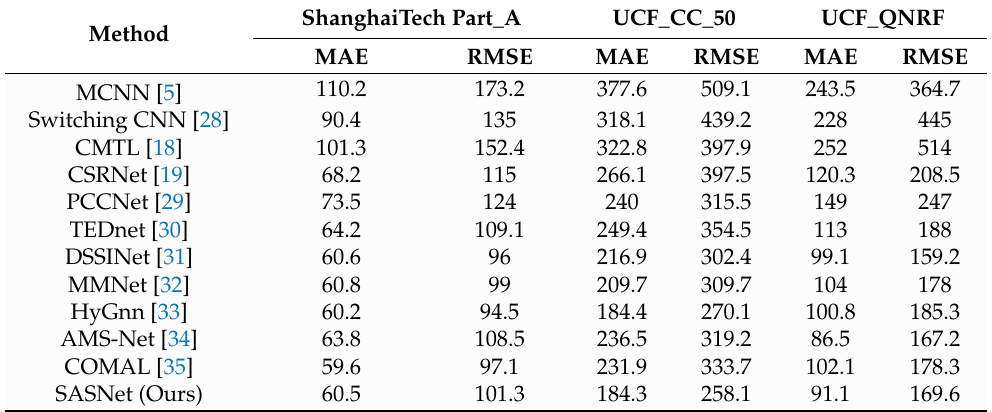
Table 2. Comparison Experiment on ShanghaiTech Part_A, UCF_CC_50, and UCF_QNRF datasets.